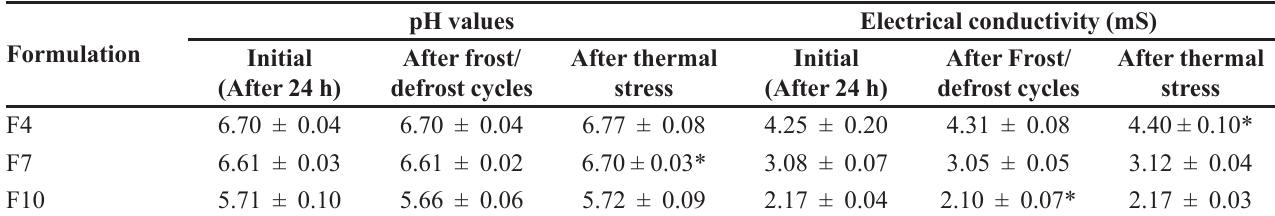
TABLE II - Results of preliminary stability tests of F4, F7 and F10 formulations added with 1% of EHG001